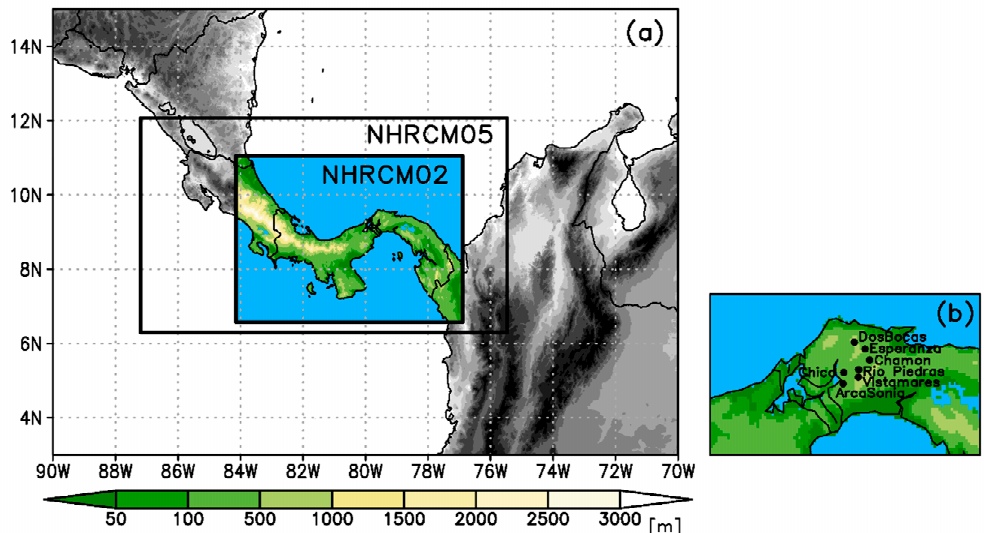
Figure 1. ( a ) Target area for current climate simulations. Inner domain (colored) represents area for NHRCM02, outer domain (grayscale) represents area for NHRCM05. ( b ) Eight ground-based precipitations stations observed by Panama Canal Authority.